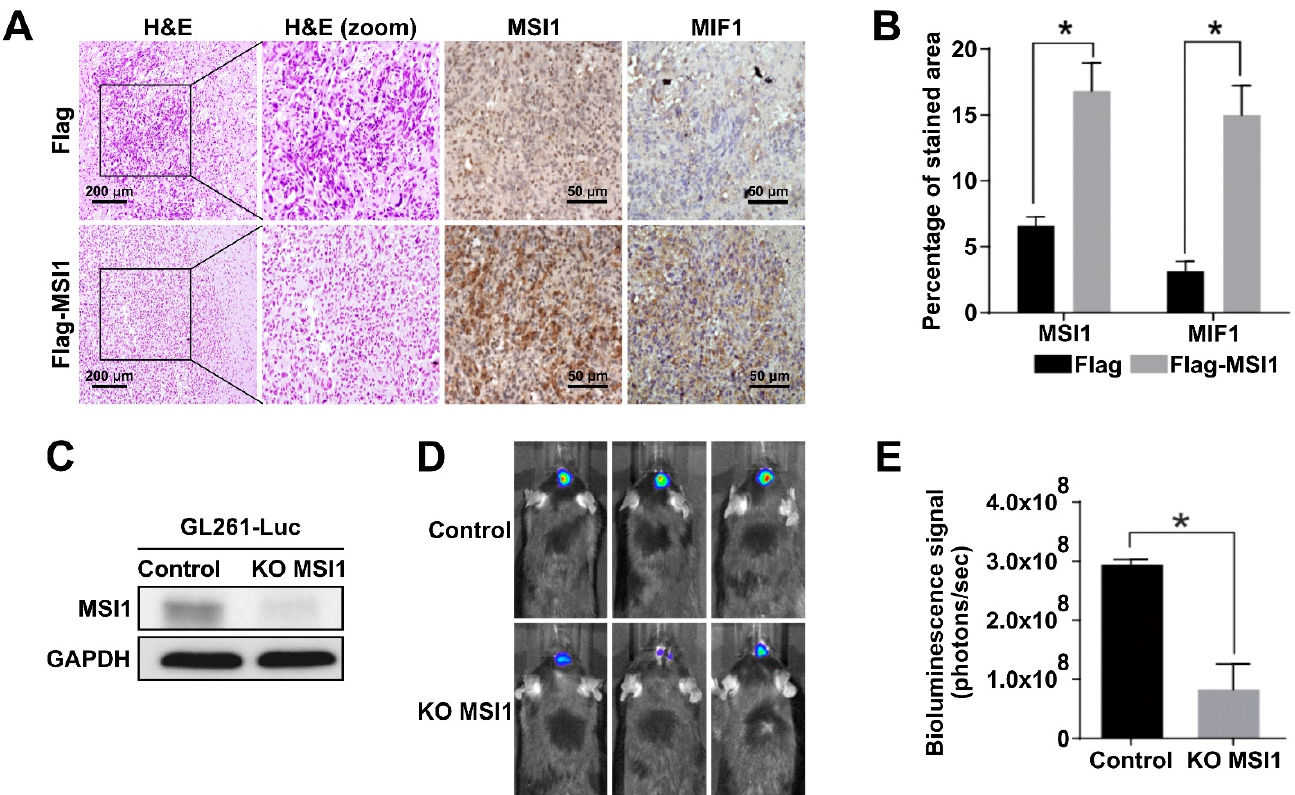
Figure 3. MSI1 expression is highly correlated with MIF1 in GBM tumor mouse models. ( A ) Immunohistostaining of MSI1 and MIF1 in cross-sections of intracranial tumors derived from xenografts of the DBTRG-05MG cells transfected with Flag–MSI1 and the control Flag-only construct. H&E staining (left panels) shows general tumor morphology. ( B ) Quantification of MSI1—and MIF1—stained areas in ( A ). Mean values are shown, n = 3, SD—error bars, * p < 0.05 (Student’s t -test). ( C ) Western blot showing the knockout of MSI1 expression in the GL261-Luc cells transfected with Cas9 only (control) or with CRISPR/Cas9 (KO MSI1). GAPDH—loading control. ( D ) Control and KO MSI1 GL261-Luc cells were subjected to an intracranial injection in 8-week-old male C57BL/6 mice ( n = 3). Bioluminescent signal visualization (IVIS) of tumors derived from control and KO MSI1 GL261-Luc cells in mice on day 14 post-injection is show€( E ) Quantification of the bioluminescence signal from tumors in ( D ); n = 3, SD—error bars, * p < 0.05 (Student’s t -test).